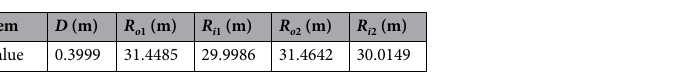
Table 4. D and Turning Radius of Four